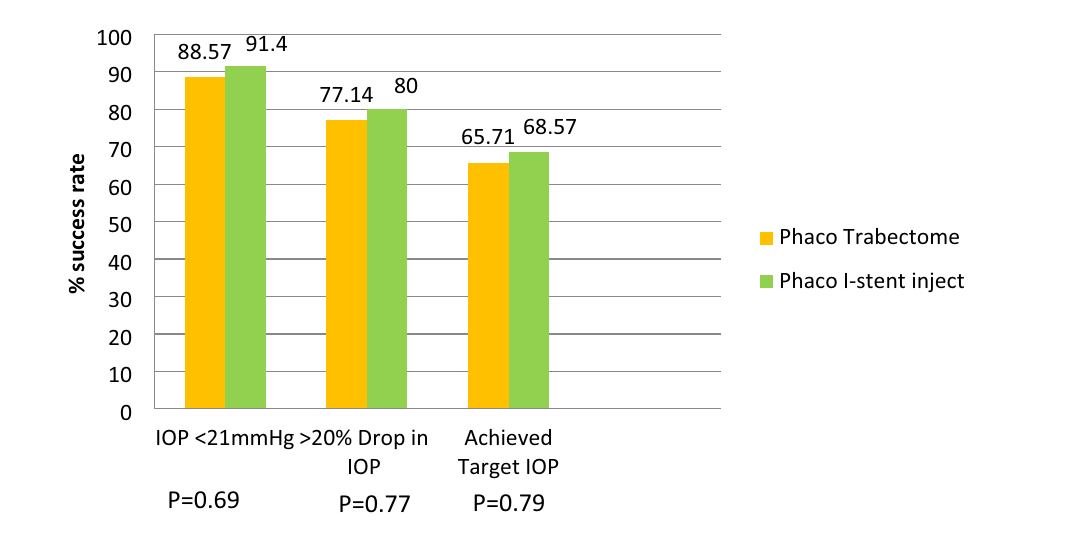
Figure 4. Success rate with different